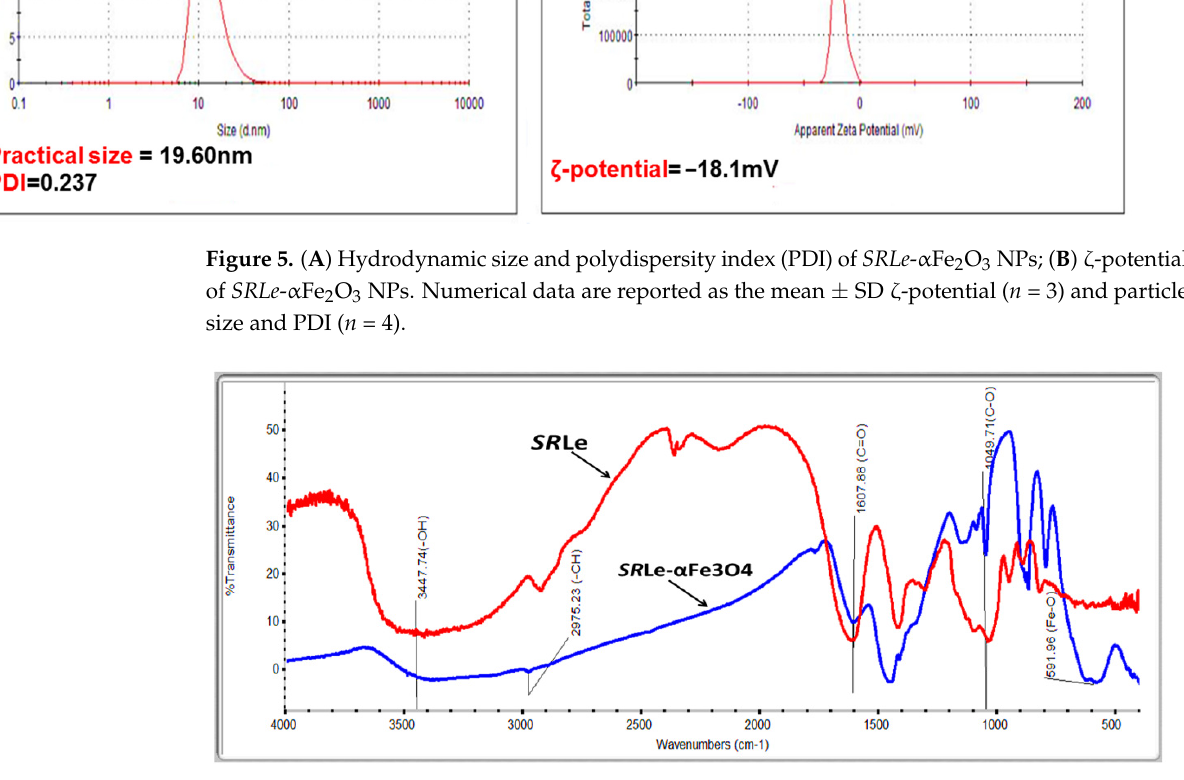
Figure 7. ( A ) UV/visible absorption spectra; ( B ) XRD analysis of SRLe - α Fe 2 O 3 NPs . 2.4.5. Surface Properties The size distribution and morphology are illustrated in Figures 8 and 9. SRLe - α Fe 2 O 3 was analyzed using TEM (Figure 8A,B) and SEM (Figure 9A–C) microscopy images matched to those obtained using DLS. Each TEM and SEM image showed particles with a spherical shape, uniform size distribution, and aggregation. The SRLe - α Fe 2 O 3 size dis- tribution for functionalized magnetite NPs was uniform with an average size of ~18 ± 2.7 nm. Similar sizes of green synthesized silver nanoparticles using fresh Sida cordifolia